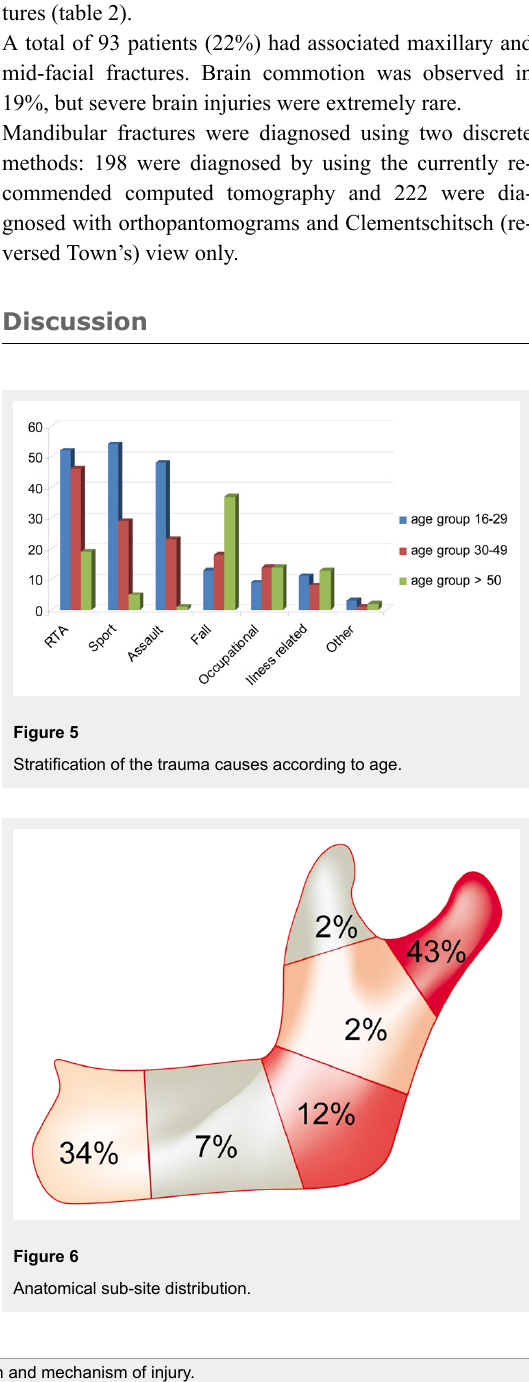
Table 2: Correlation of fracture site and trauma